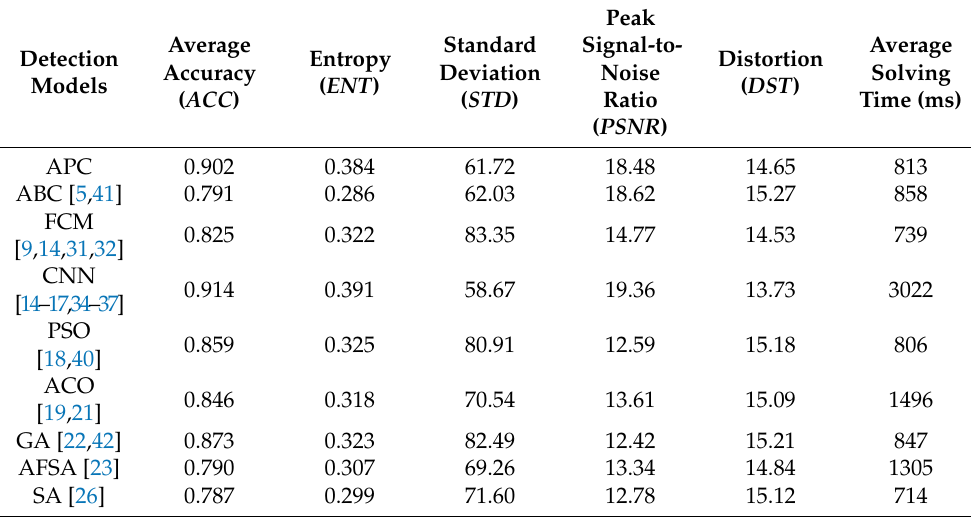
Table 4. Comparison of results of different models on the Pascal VOC dataset.